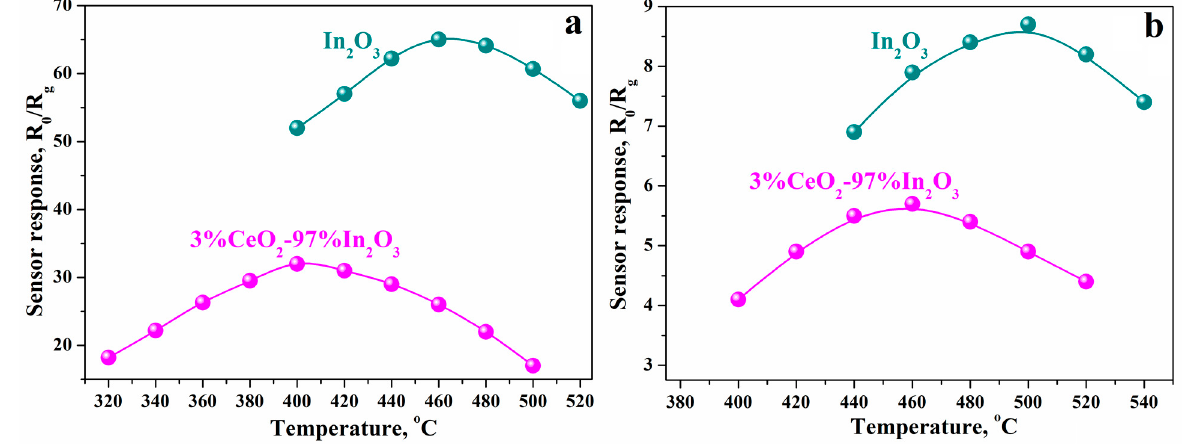
Figure 10. Temperature dependence of the sensor response of pure indium oxide and 3%CeO 2 –97%In 2 O 3 composite during detection of: ( a ) 9900 ppm H 2 ; ( b ) 970 ppm CO. 97%In 2 O 3 composite during detection of: ( a ) 9900 ppm H 2 ; ( b ) 970 ppm